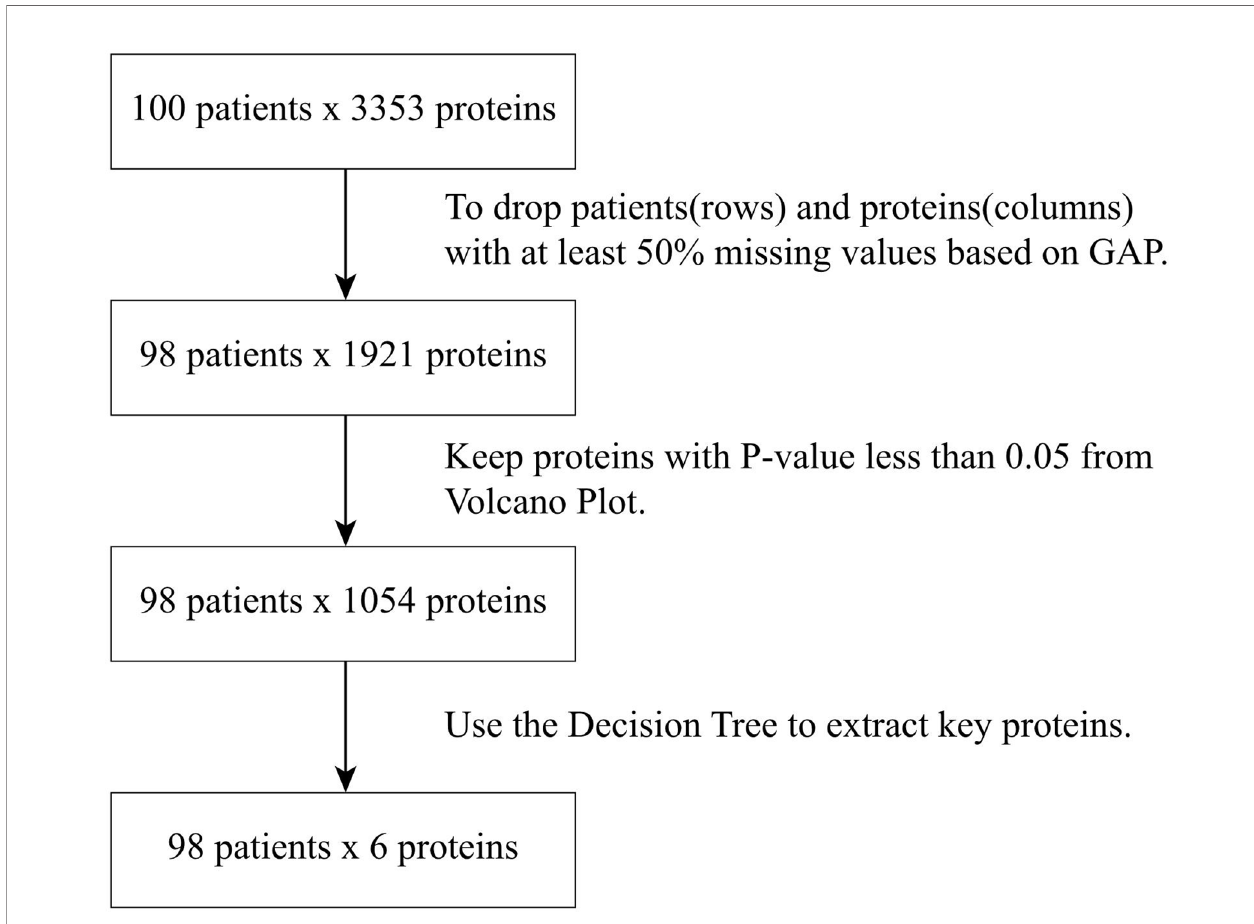
FIGURE 1 | Flowchart of protein selection and data analysis